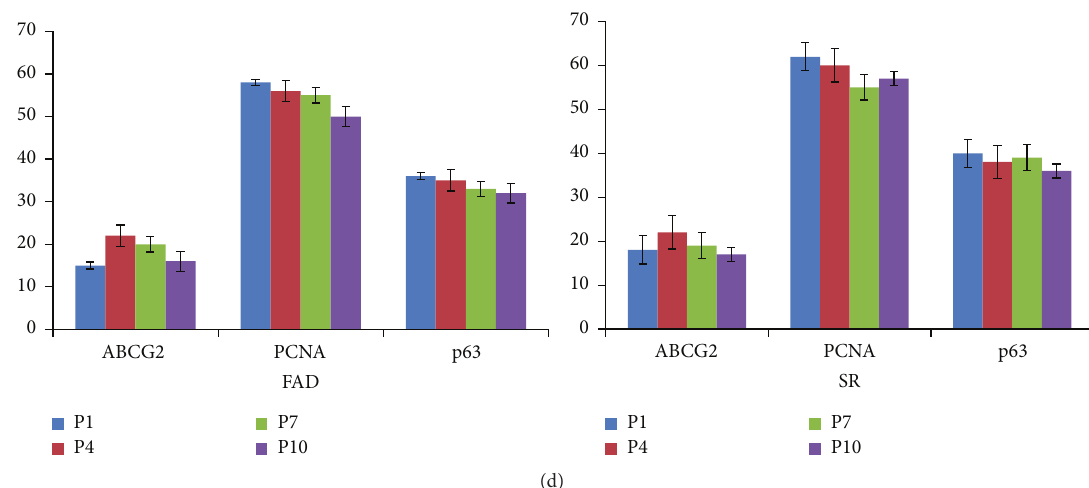
Figure 3: Gene expression and protein expression in human limbal epithelial cells. (a) Gene expression analysis of human limbal epithelial cells. PCR data shows that the cells cultured in both FAD medium and SR medium show high level expression of proliferation transcript PCNA in P1, P4, P7, and P10. The cells in both media show positive expression of cytokeratin 3 and cytokeratin 12, which implies their limbus origin. The positive expression of basal layer epithelial cell marker, cytokeratin 15, was also observed in both cultures. ABCG2 and Δ Np63 𝛼 expression was detected in both cultures; their expression was observed to be decreased slightly after passage 7 (P7) in both culture media. The low level of connexin 43 (Cx43) expression was observed in both cultures and implied low level of epithelial cell differentiation in both media. (b) Quantitative real-time PCR analysis of human limbal epithelial cells cultured in SR and FAD media. Real-time PCR was performed on epithelial cells cultured using both FAD and SR media. Housekeeping gene GAPDH was used as an internal control. Analysis of the limbal epithelial stem cell markers p63 and ABCG2 mRNA found that there was no significant difference ( 𝑝 > 0.05 , 𝑛 = 5 ) in expression between epithelial cells grown in FAD and SR media. Real-time analysis of the corneal epithelial differentiation marker cytokeratin 3 and connexin 43 was performed. All these markers were barely detectable in both FAD and SR cell cultures, and, surprisingly, there is no significant difference ( 𝑝 > 0.05 , 𝑛 = 5 ) of expression level between these two cultures. All the real-time PCR experiments were carried out in triplicate. (c) Western blot assay of human limbal epithelial cells cultured in FAD and SR media. The expression of proliferation marker (PCNA) and potential epithelial stem cells markers (p63 and ABCG2) was evaluated using western blot. Using monoclonal antibody clone 4A4, the p63 protein (70 KD) was detected at high expression level in SR medium. The expression of ABCG2 was detected in each passage of cells cultured in SR medium. PCNA, the cell nucleus antigen, a cell proliferation marker, was also detected in epithelial cells cultured in SR medium. (d) The expression of ABCG2, p63, and PCNA was quantified and plotted using semiquantitative intensity measurement. The blot density of ABCG2, p63, and PCNA was measured and normalized to the level of